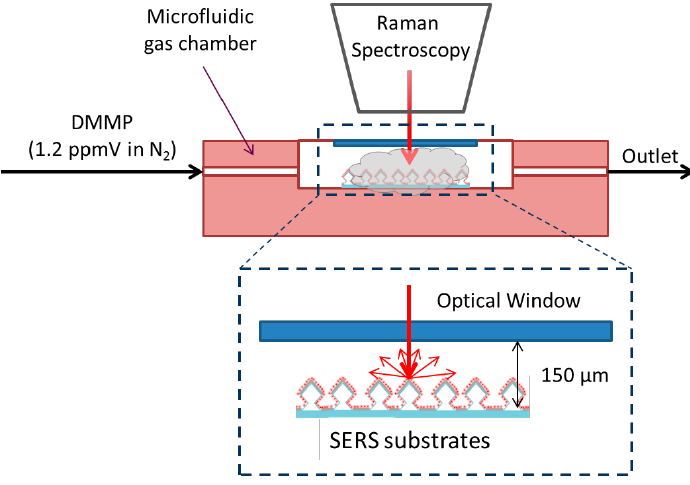
Figure 4. Experimental set-up for continuous SERS measurements of DMMP in gas phase.